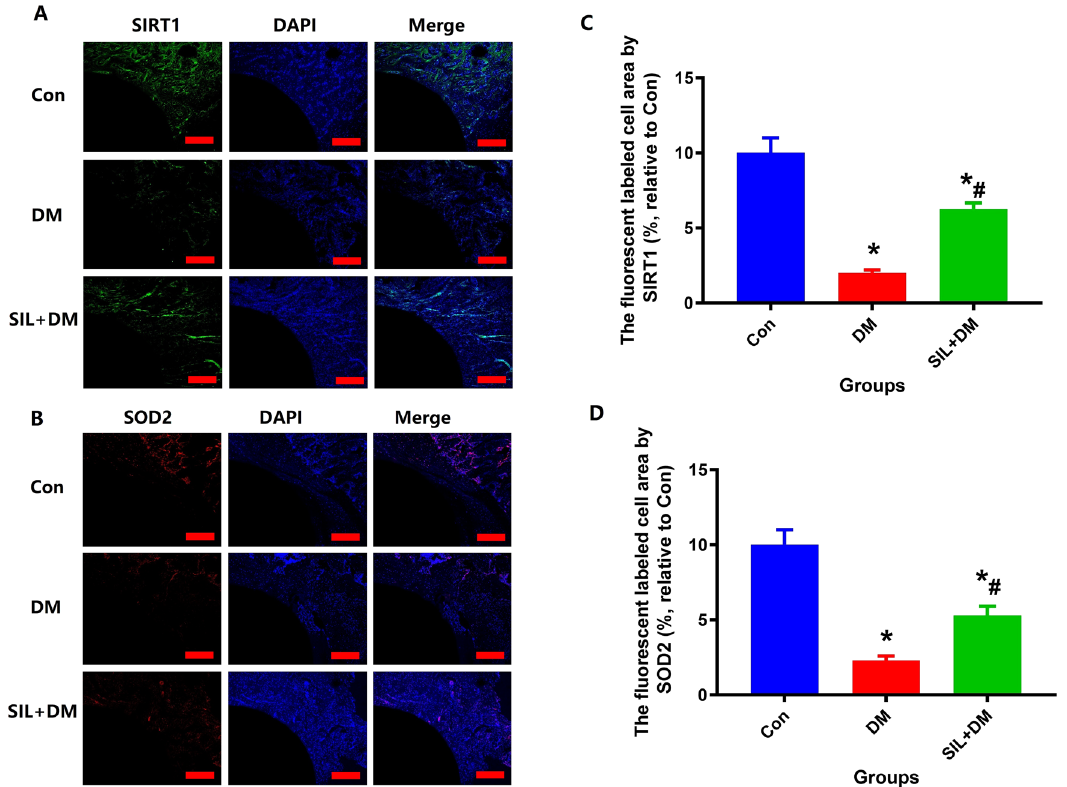
Fig. 6 Local administrator SIL can signi fi cantly improve the expres- sion of SIRT1 and SOD2 around titanium rod in diabetic rat model. Representative pictures of SIRT1 ( A ) and SOD2 ( B ) expression in bone tissue around titanium rod measured by immuno fl uorescence;